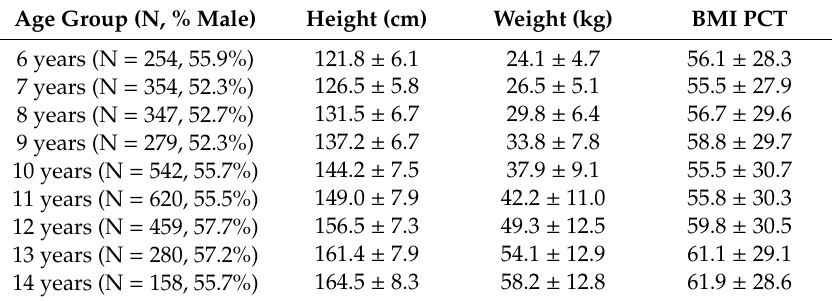
Table 1. Anthropometric characteristics by age group. Values are mean ±